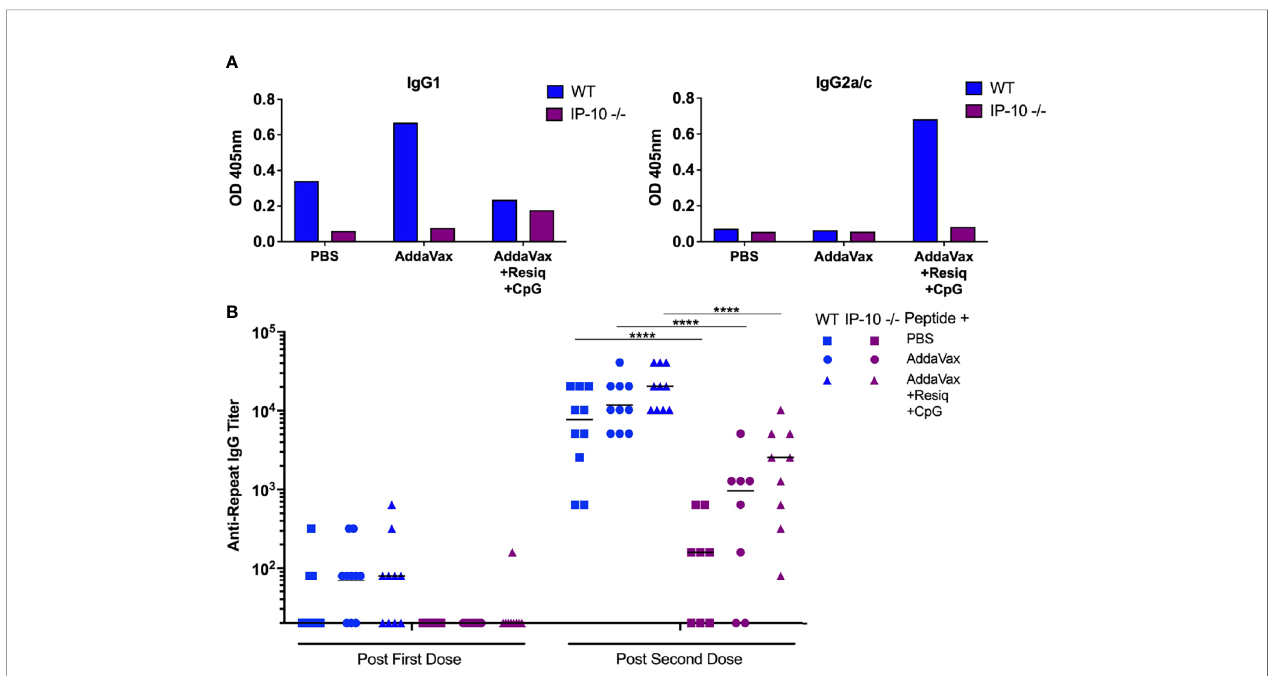
FIGURE 6 | Anti-repeat antibody responses in IP-10 -/- mice post SS prime and boost. (A) IgG1 (left panel) and IgG2a/c (right panel) anti-CS repeat antibodies were measured by ELISA in pooled serum (3-4 mice/group) in IP-10 -/- mice (purple bars) or WT controls (blue bars). Serum was collected following SS prime and boost with CS peptide in PBS, Addavax or Addavax + Resiquimod + CpG. Results are shown as OD at 1:80 serum dilution. (B) Anti-repeat antibody response in serum of individual IP-10 -/- mice (purple symbols) compared to WT mice (blue symbols) following SS prime and boost with CS peptide without adjuvant (PBS), with AddaVax, or with AddaVax + Resiquimod + CpG. Results of two experiments were pooled with individual mice shown as data points and geometric mean indicated by bar. One-way ANOVA of log-transformed values followed by Bonferroni ’ s multiple comparisons test with adjusted p values, ****p